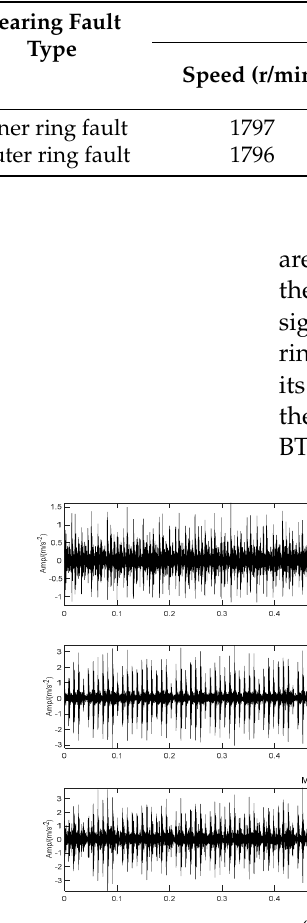
Table 2. The test platform parameters.